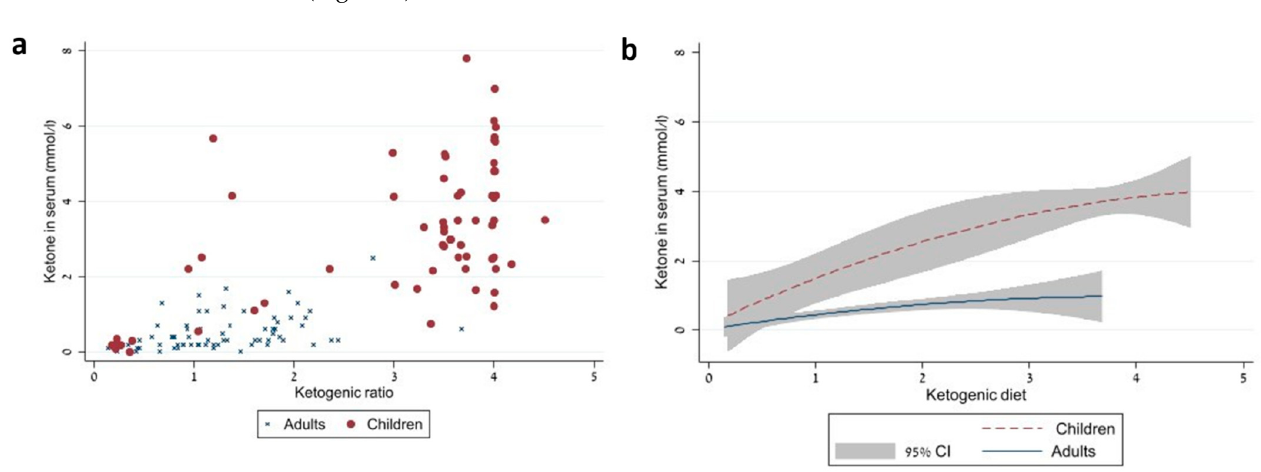
Figure 1. Correlation between dietary ketogenic ratio and blood ketone levels in the two populations: children vs. adults ( p < 0.0001). The raw data are presented in panel ( a ), quadratic modeling is presented in panel ( b ).